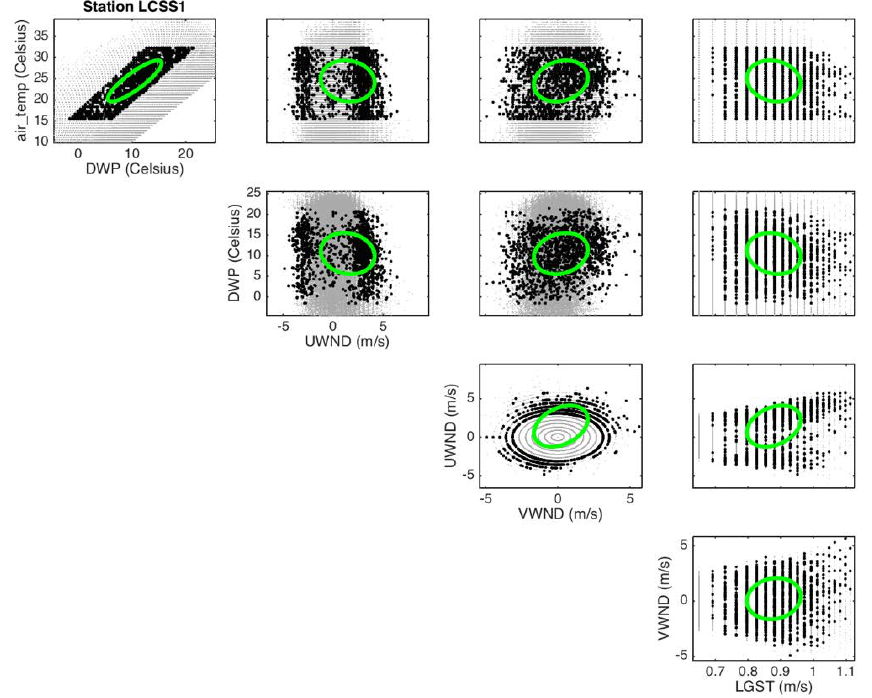
Figure A8. As in Figure 4 but for station LCSS1.